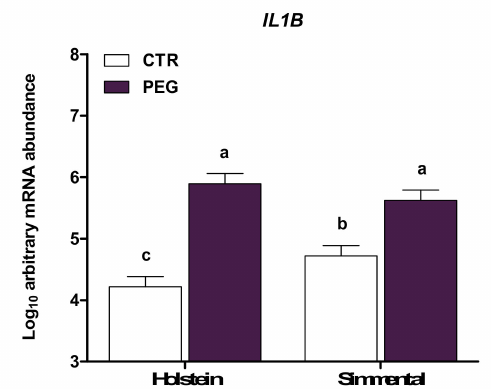
Figure 6. LSM ± SEM of Log10 arbitrary mRNA abundance for gene expression of IL1B (interleukin 1 beta) evaluated three days after calving in Simmental and Holstein cows treated either with pegbovigrastim (PEG) or with saline (CTR) at approximately Day 7 relative to calving and on the day of calving within 24 h. Di ff erent letters represent significant di ff erences among groups at p ≤